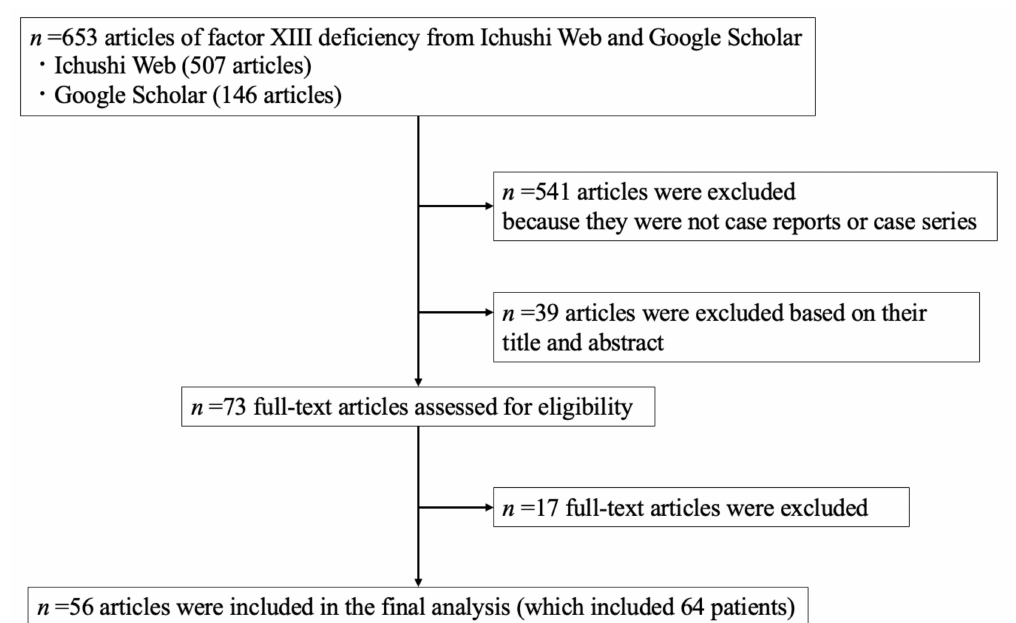
Figure 4. Study selection